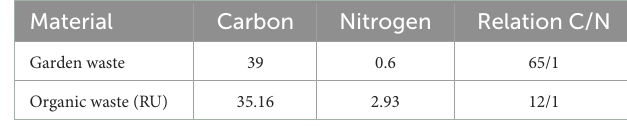
TABLE 1 Initial characterization of residues.